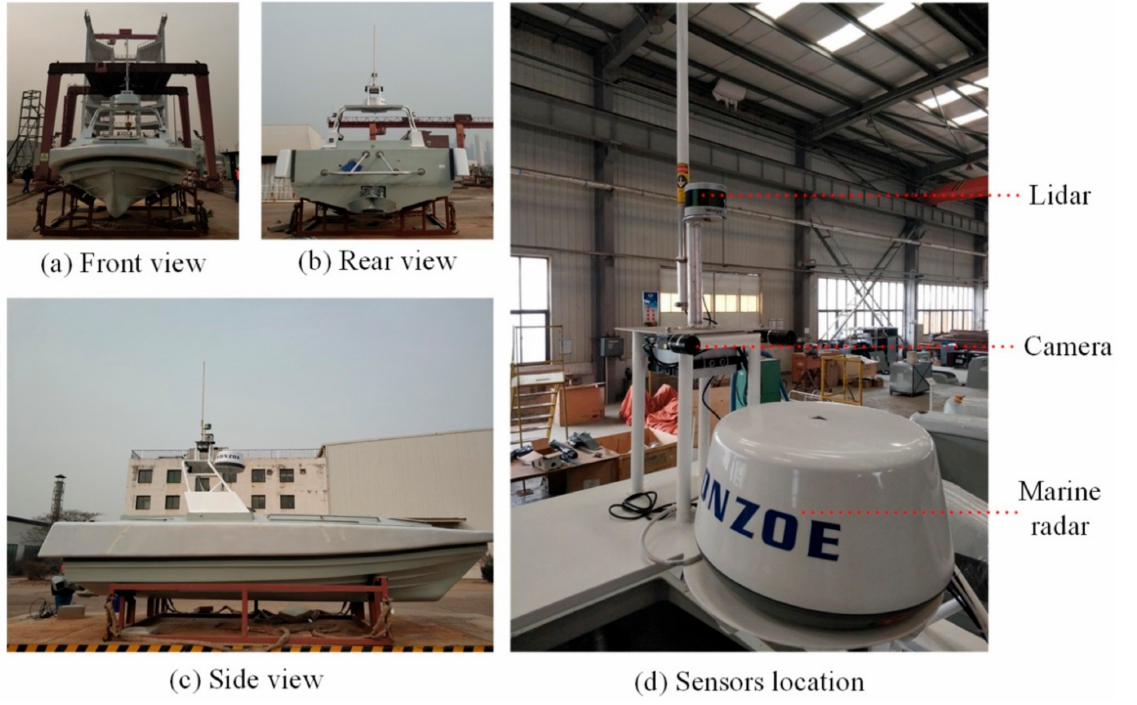
Figure 1. Multimodal sensor system for